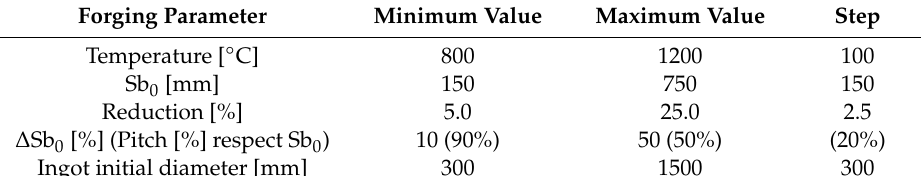
Table 1. Parameters of FEM simulation for stretching forging process for round ingot.